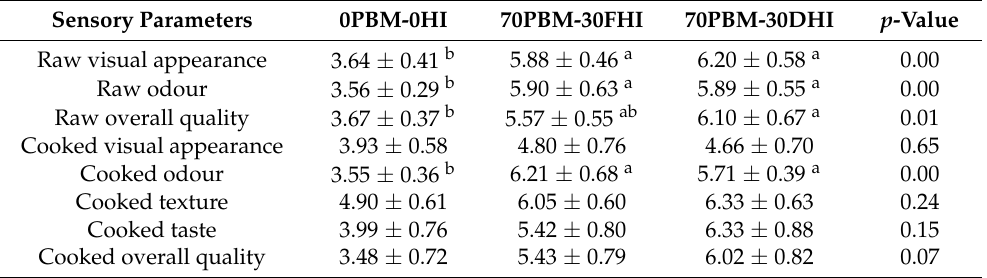
Table 4. Sensory attributes of the fillets of barramundi fed with a mixture of poultry by-product meal (PBM), full-fat Hermetia illucens (FHI), and partially defatted Hermetia illucens (DHI) larvae meal for the complete replacement of fishmeal (FM). The values are the means of nine biological replicates ± the standard error (SE). Means with different superscript letters within the same row indicate significant differences, while means with no superscript letters indicate no variation among the treatments. Means were compared using a one-way ANOVA with Tukey’s post-hoc multiple comparisons test at p <